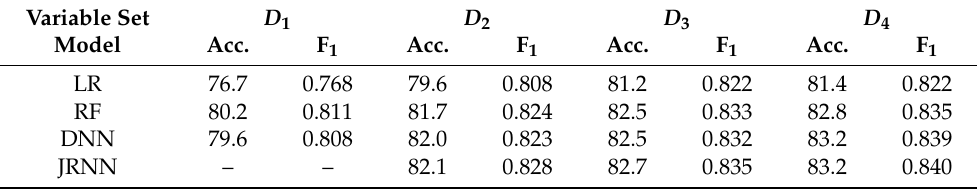
Table 7. Overall accuracy (%) and F 1 scores from cross-validation using all available field observations. Variable Set D 1 D 2 D 3 D 4 Model